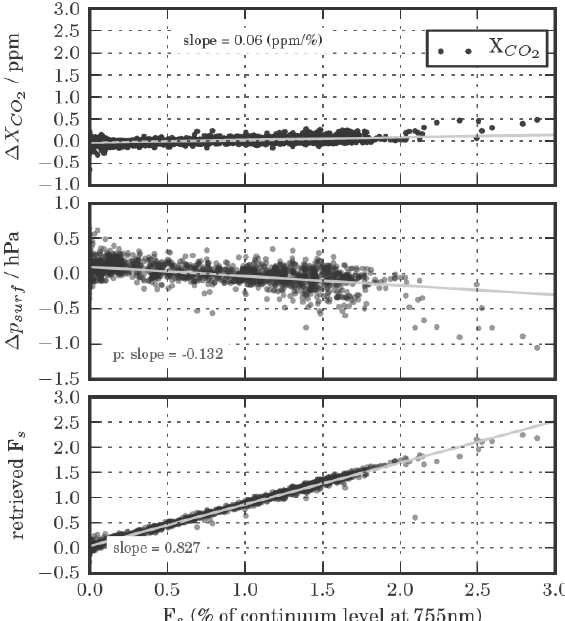
Fig. 6. Case #1b: Changes in retrieved X CO phyll fluorescence if fluorescence is fitted. Both simulation and re- trieval use a Rayleigh-only